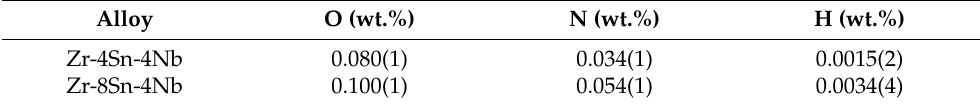
Table 2. Oxygen, nitrogen, and hydrogen content in the studied